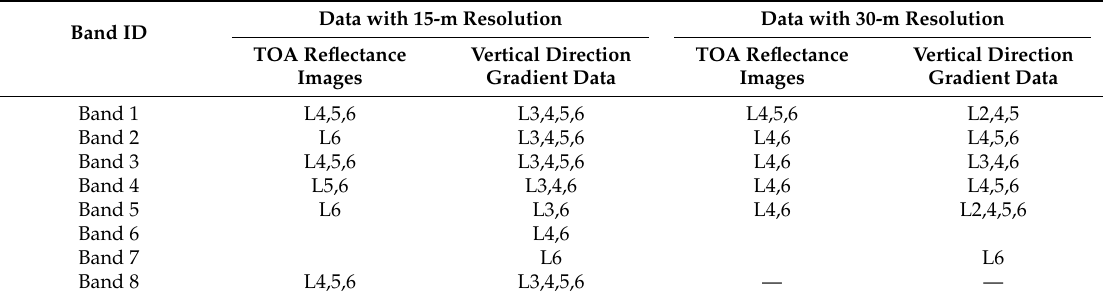
Table 9. List of detected tidal cracks (by numerical labels in Figure 2) with lengths greater than 500 m generated by matching detected lines with field